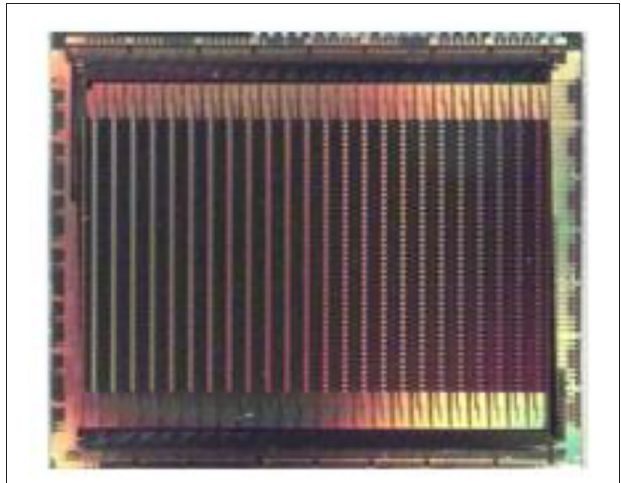
FIGURE 6 | A deep neuromorphic ANN chip with 2.4 million memristor devices ( Kataeva et al., 2019).